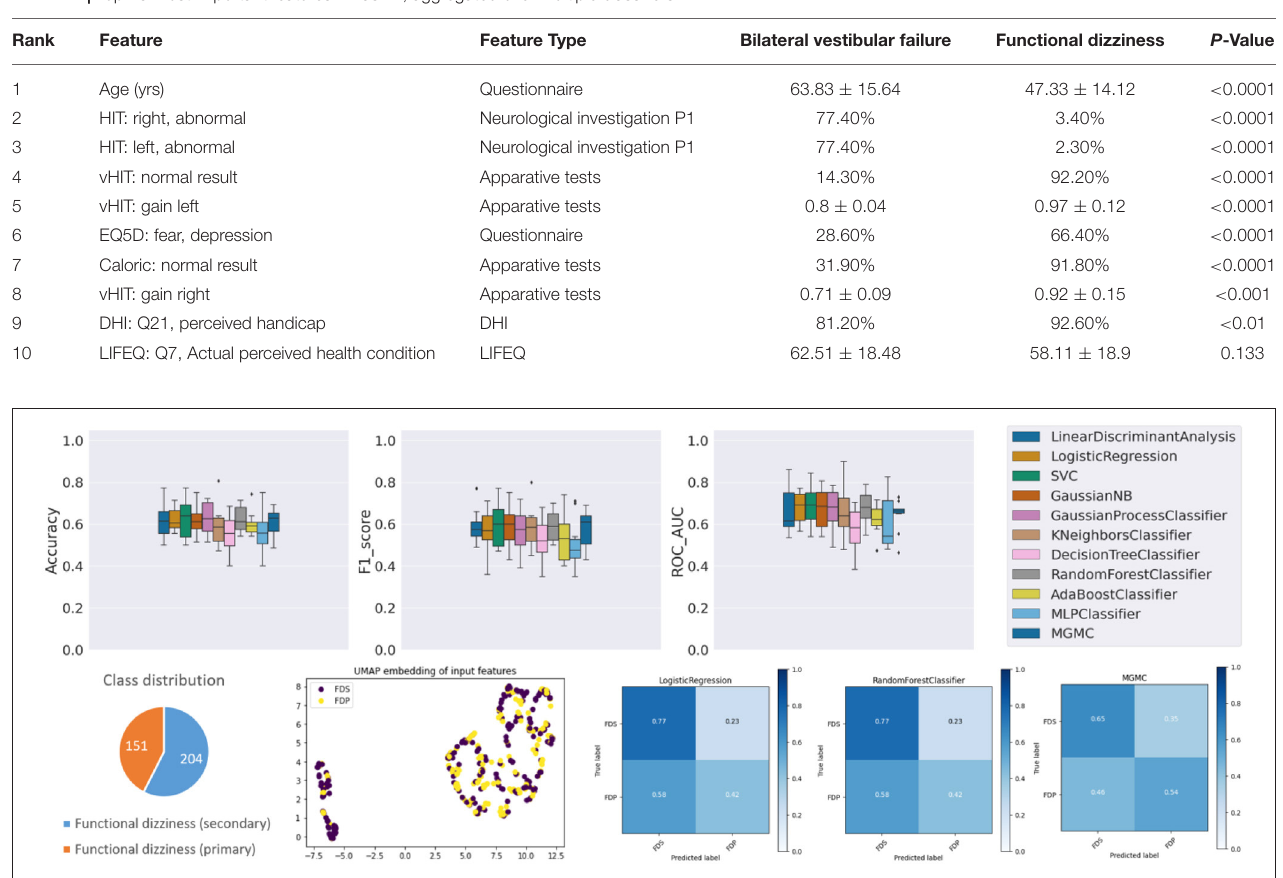
TABLE 2 | Top 10 most important features in Task 1, aggregated over multiple classifiers.